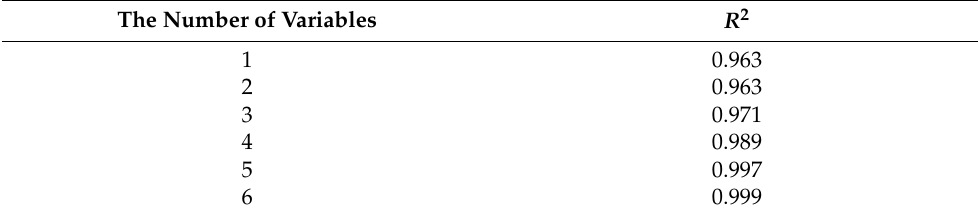
Table 6. Sample determination coefficient R 2 .